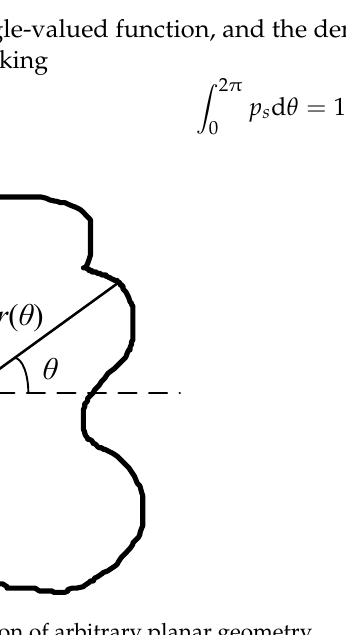
Figure 1. An illustration of arbitrary planar geometry.